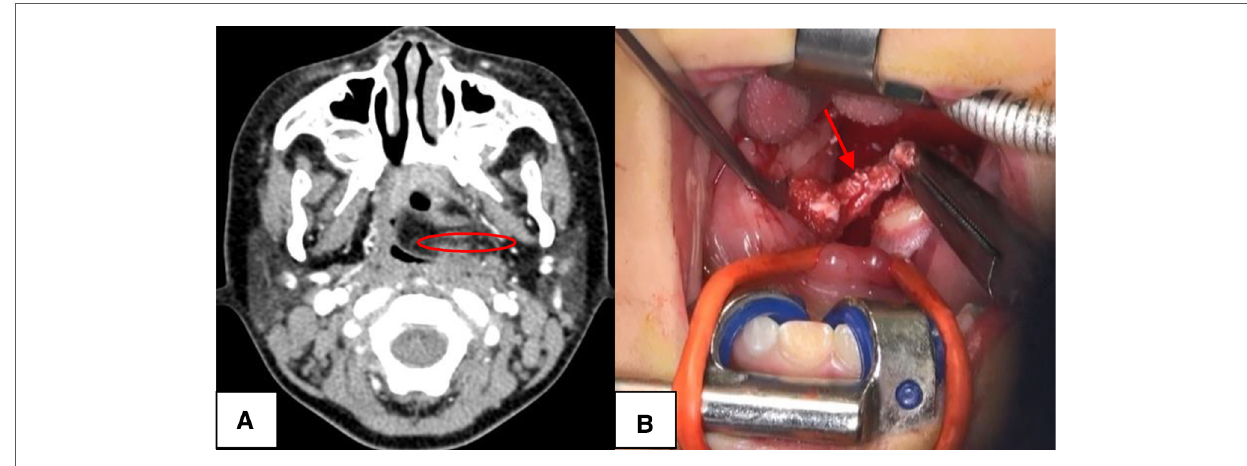
FIGURE 4 The Bailey type IV. ( A ) The lesion (red circle) was toward ipsilateral pharynx to end up to the palatine tonsil, blocking the oropharynx. ( B ) The case underwent complete surgical excision with ipsilateral tonsillectomy (red arrow), via external cervical approach combined with oral approach.